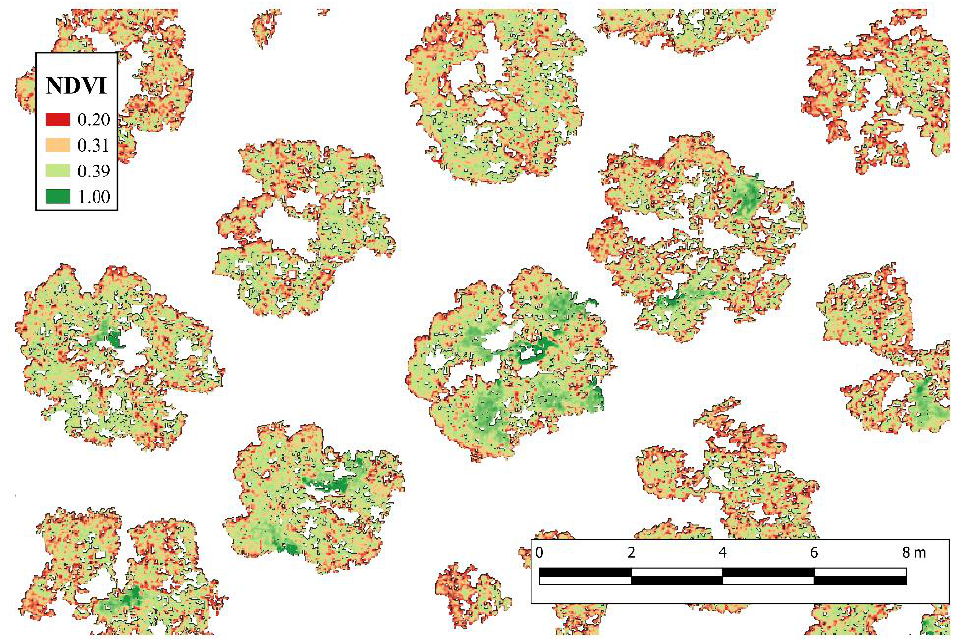
Figure 4. Canopy area and NDVI value for each plant in a portion of the plot. Total olive yield during the study year was 2.8 t, corresponding to 4.8 t ha − 1 (12.8 kg plant − 1 ). Olive production and canopy area based on NDVI were overlapped in Figure 5, also showing a certain variability in olive yield. The amount of N to be applied ranged from 7.5 to 18.5 g per square meter, correspond- ing on average to 255 g per plant. Figure 6 represents the prescription map of the amount of N to be applied. The plants were grouped into four different classes, according to the corresponding